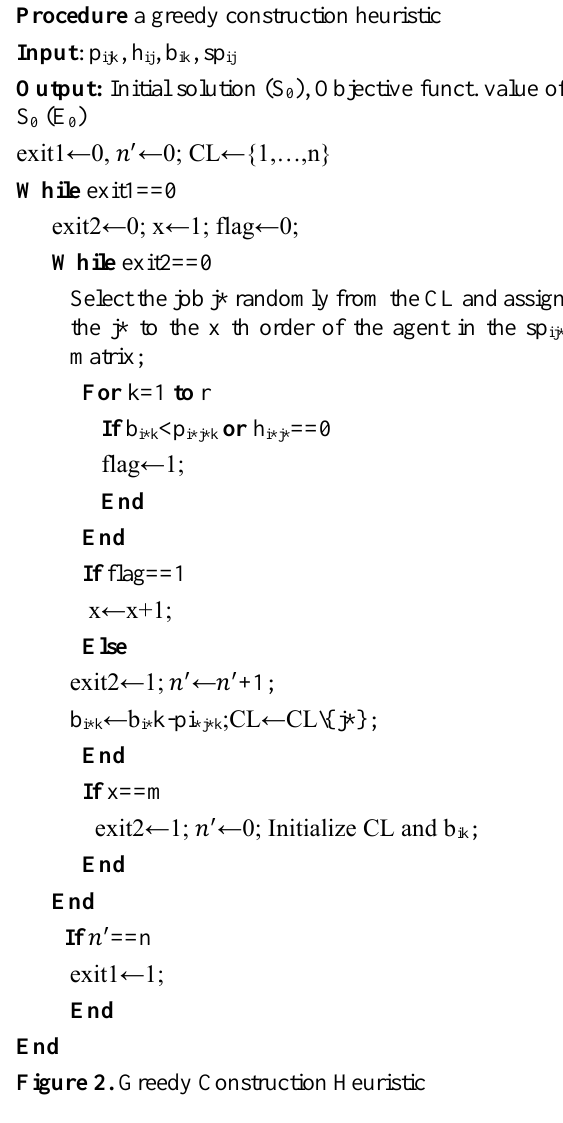
Procedure a greedy construction heuristic